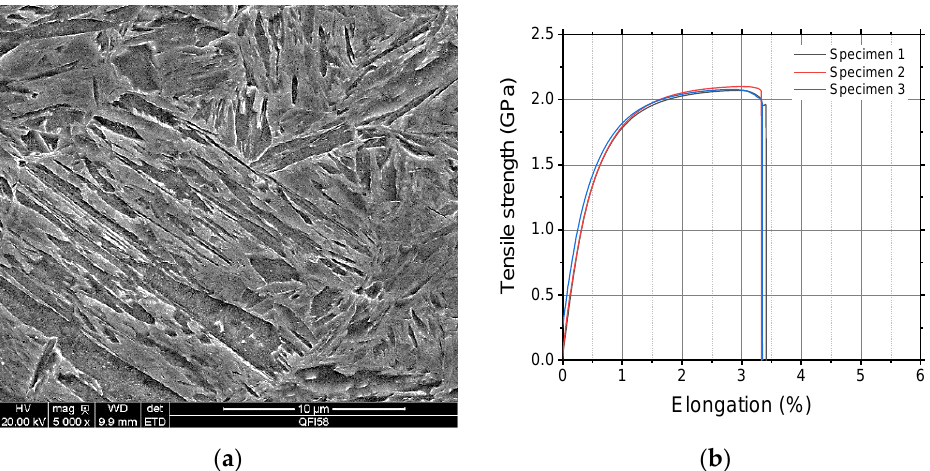
Figure 4. Characteristics of base material: ( a ) SEM image of the base metal (5000× magnification) and ( b ) tensile test result.